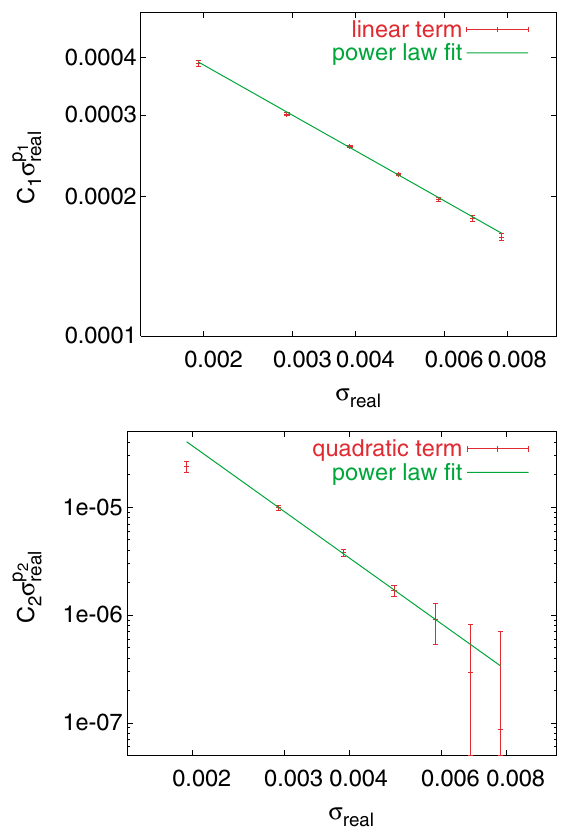
FIG. 3. (Color) Power-law fits to parabolic coefficients as de- scribed in the text. The smallest value of (cid:1) the quadratic term fit to avoid contamination from higher-order terms in the